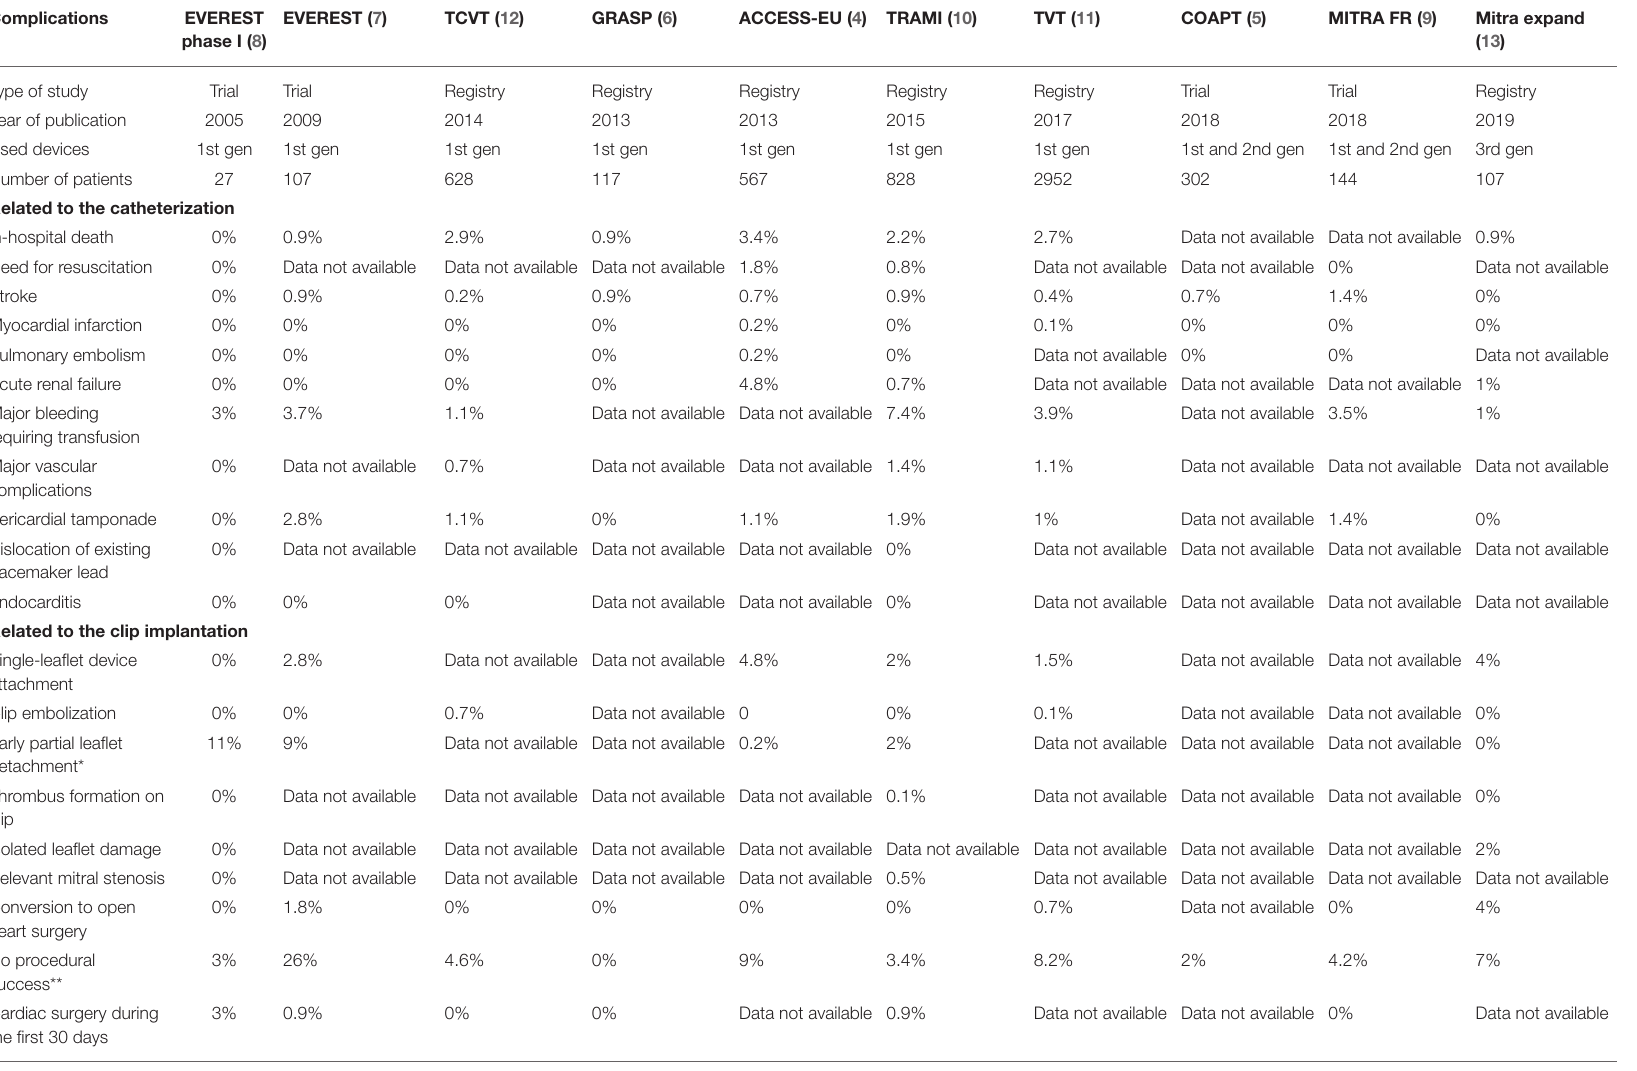
TABLE 1 | Complications during and after Mitraclip